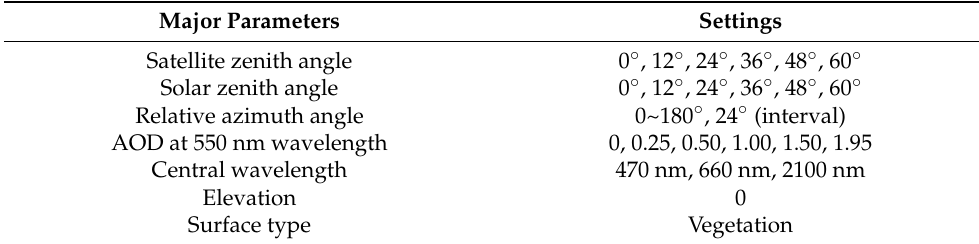
Figure 2. The flow chart of AOD inversion. Table 3. Geometric parameters of LUT based on a 6 S transmission